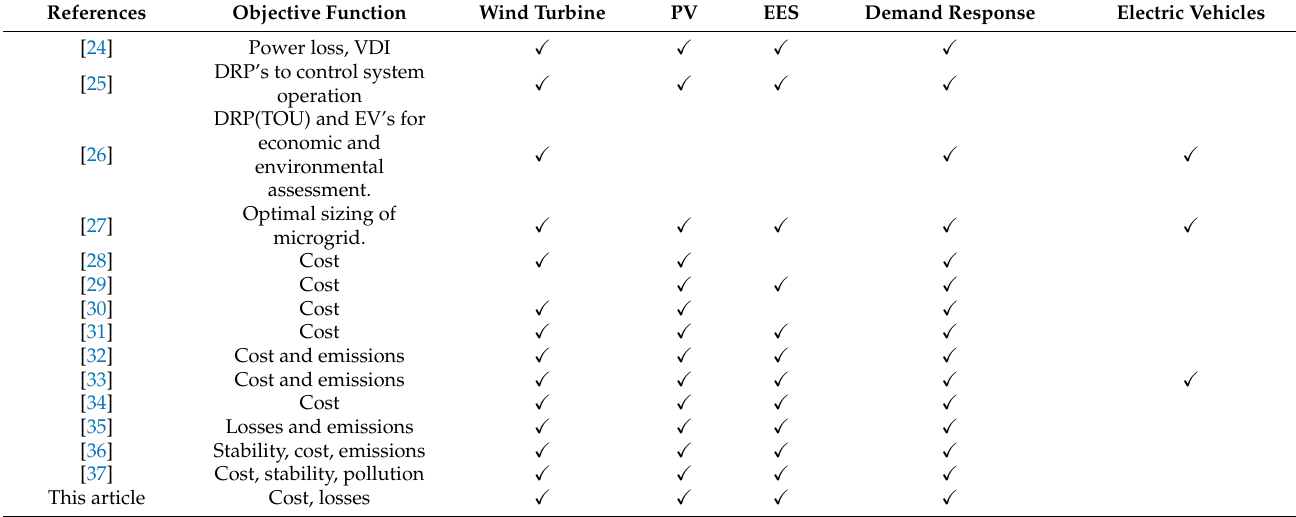
Table 1. Comparison of this model with existing works.